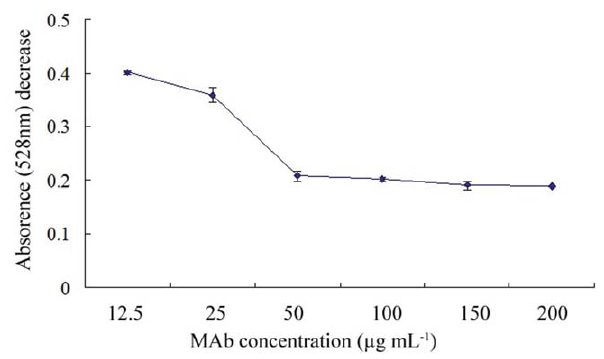
Figure 4. Reading time curves. Each point on the y axis represents the average value for the G/Peak - ROD, and the x axis values are the time after the addition of the working buffers